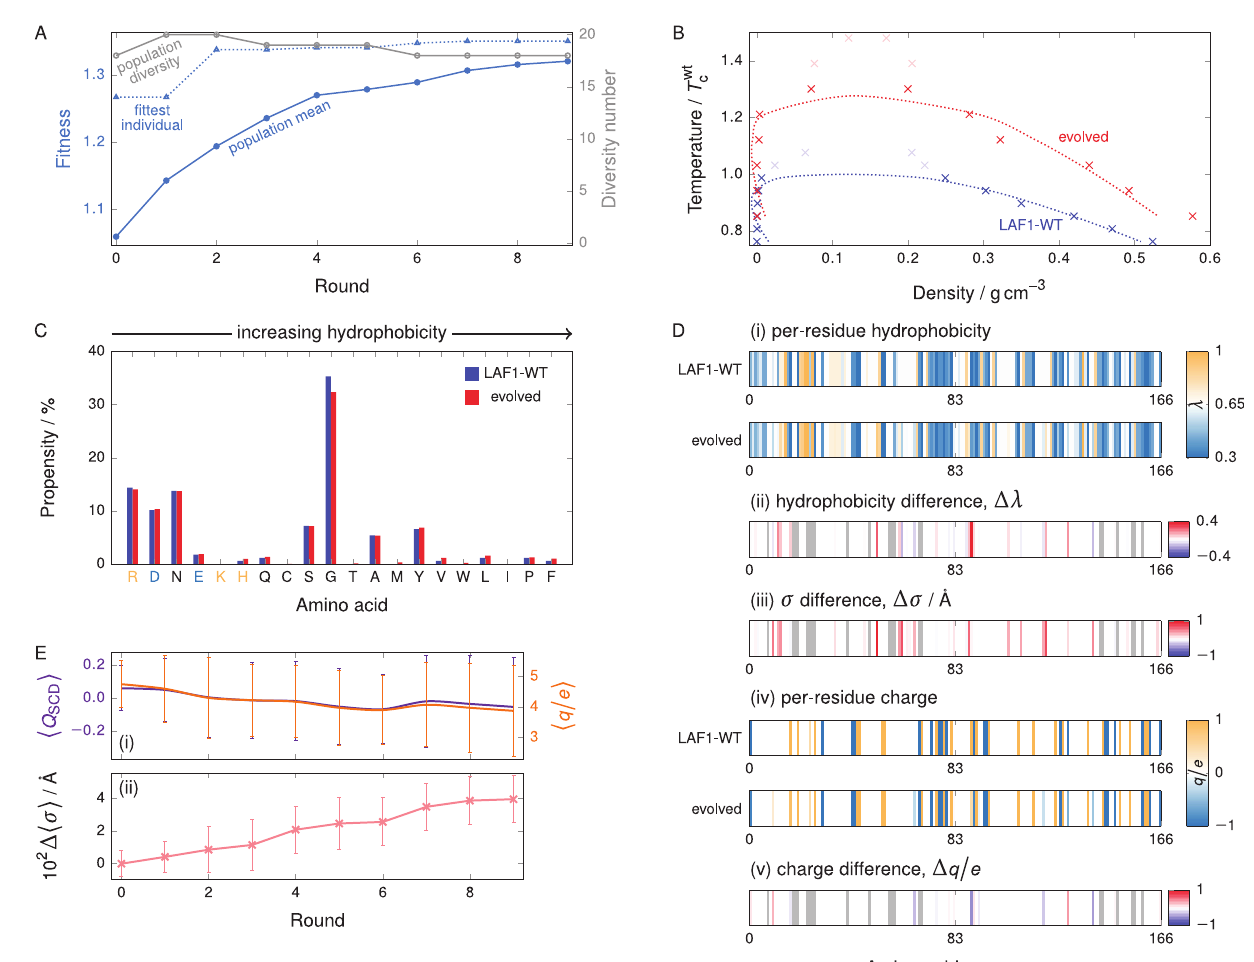
Fig 5. Evolution of LAF1 IDR. (A) Typical GA progression for LAF1. The fitness function [Eq (2)] was evaluated at T ¼ 0 : 85 T wt * 30% over 9 rounds, while maintaining population diversity. To account for thick interfaces, the simulation box was doubled in all directions compared to simulations of FUS and hnRNPA1. (B) Comparison of representative phase diagrams before and after genetic-algorithm runs. Although the phase diagram close to the critical point is especially difficult to equilibrate because of interfacial effects in this system, data points at lower temperatures suggest that the critical temperature increases by * 30% by the end of the GA optimisation. (C) Amino-acid composition before and after genetic-algorithm runs targeting an increase in T c for LAF1. There is a slight general increase in hydrophobicity, whilst hydrophilic and charged residues are largely conserved. Amino acids are plotted in order of increasing hydrophobicity [see Table A in S1 Text]. Positively charged amino acids are indicated in light orange and negatively ones in light blue. (D) Map of (i) the per-residue hydrophobicity along the sequence, (ii) the change from WT LAF1 to the evolved protein, (iii) the per-residue change σ value and (iv), (v) analogous maps for the charge. Data are shown for one genetic-algorithm run, and those residues where no change was attempted by the genetic algorithm are shown in light grey. Partial charges reflect only partial carriage in the population. There is a slight overall increase in hydrophobicity across the sequence, and there are more charges lost than created during the course of the genetic-algorithm runs. As opposed to the hydrophobicity, the σ values increase for almost all those residues that were changed by the genetic algorithm. More charges are lost than created during the course of the genetic-algorithm runs. (E) (i) The sequence charge decoration (SCD) and the charge number ( q / e ) of the population decrease slightly over the course of the genetic-algorithm run. (ii) The average σ value of the amino acids in the population increases over the course of the genetic-algorithm run. Error bars are standard deviations of the averaged σ value of individual sequences with respect to the population.